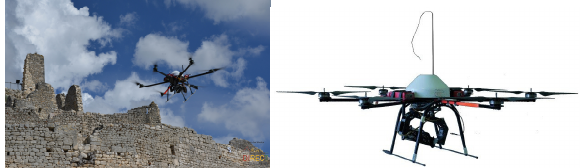
Figure 2. The employed platform - UBIK DIATI